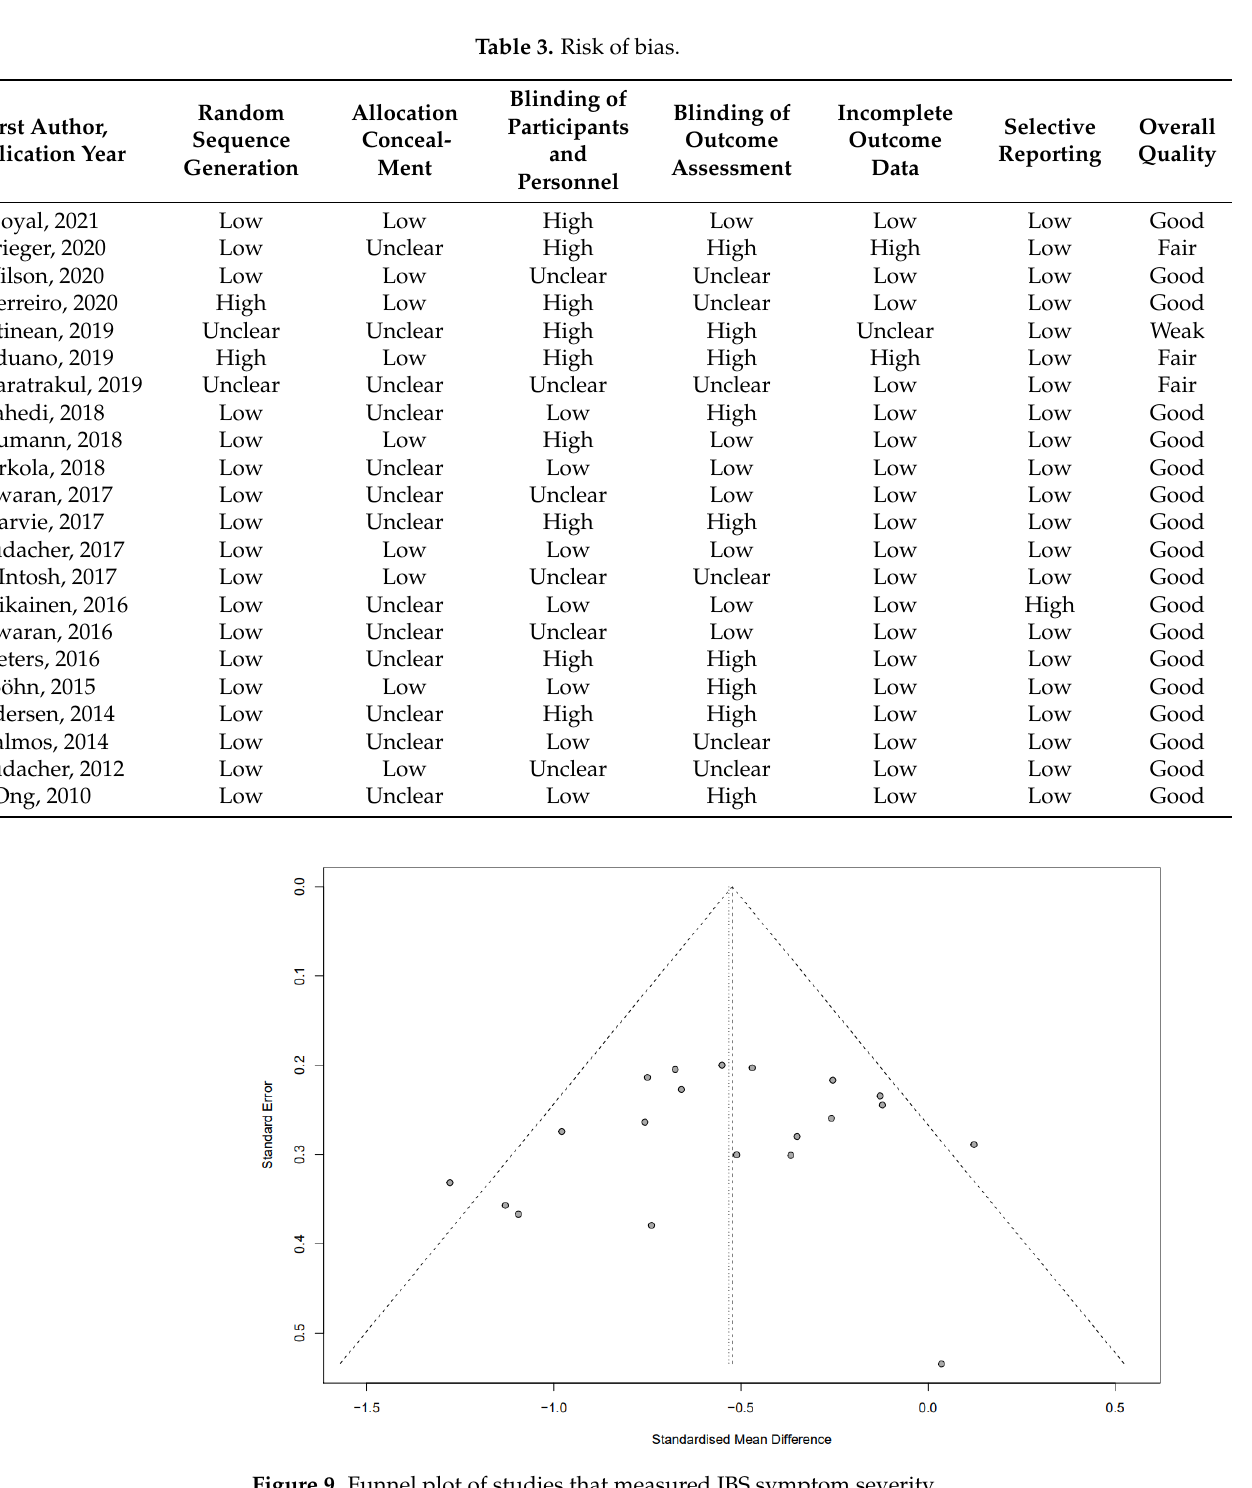
Figure 9. Funnel plot of studies that measured IBS symptom severity.